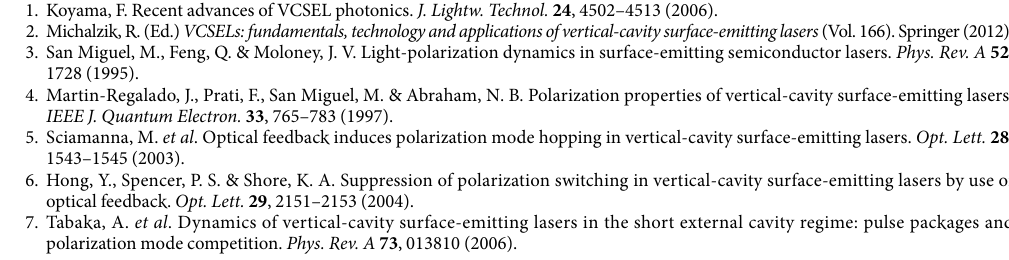
insets in Fig. 8(a1)–(a3) by eye diagrams 23 of six spikes. It can be seen that, the timing jitter 23 is about 2 ps (9 ps) for SNR = 30 dB (20 dB). Compared to the values of Δ t 1 and Δ t 2 shown in Fig. 5, the timing jitters are small and negli- gible. Hence, in temporal coding process, the timing jitter can be neglected by properly selecting the EIOP strength.